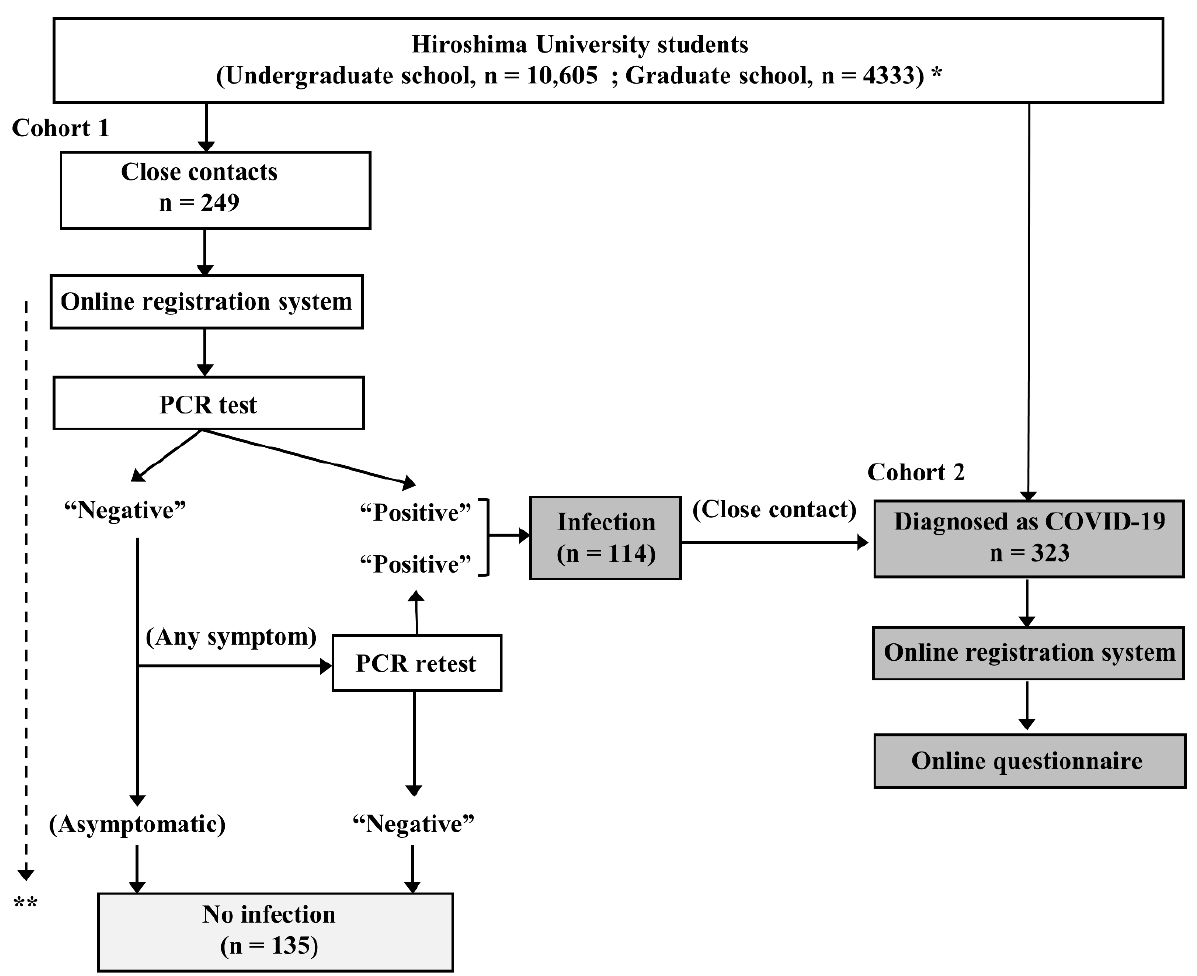
Figure 1. Study chart. * As of January 1, 2022. ** Close contacts were followed up for at least 10 days from their last contact with a COVID-19 patient. COVID-19 = coronavirus disease 2019; PCR = polymerase chain reaction.